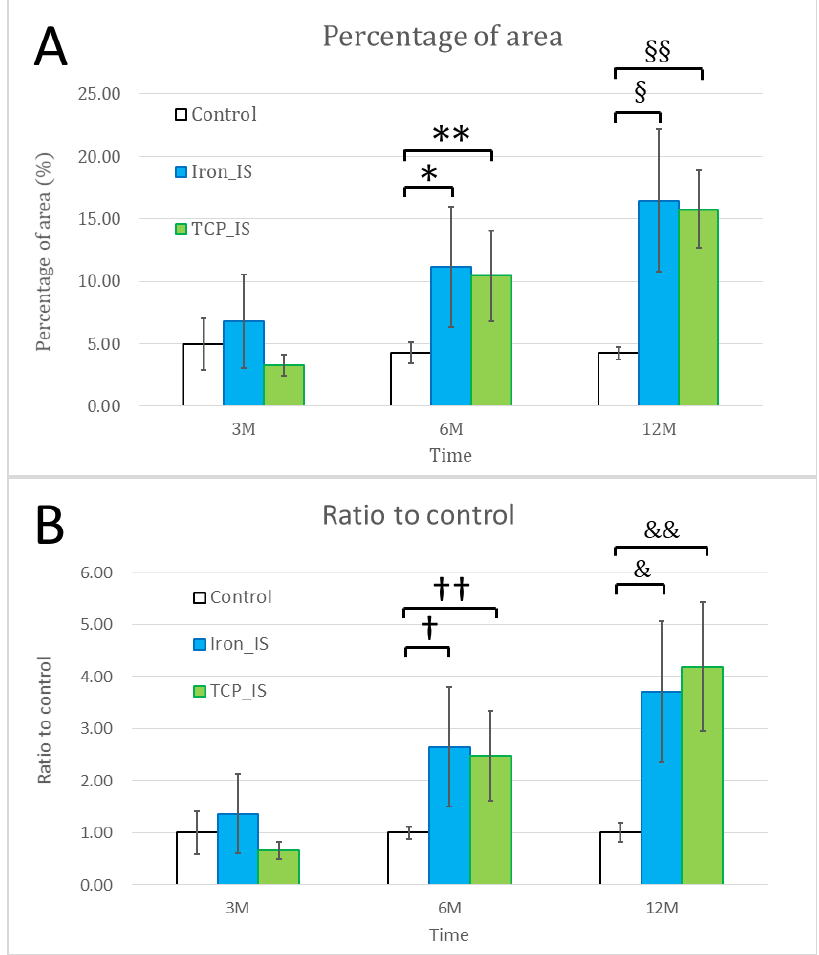
Figure 9. Semi-quantification of iron in spleen using Prussian blue special staining. ( A ) Percentage of area (%) was calculated as special stain area on a slide divided by the total specimen area on the same slide. ( B ) Ratio-to-control was calculated as percentage of area of experimental specimens divided by that of control specimens. Error bars represent standard deviations. *, **, §, §§, †, ††, &, and && denote significant differences between groups.